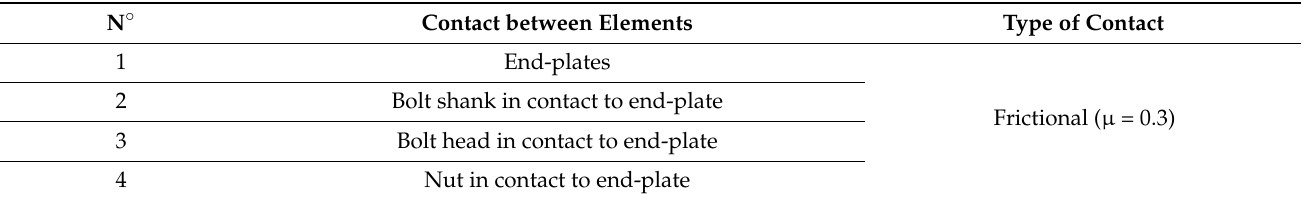
Table 4. Contacts simulated by using